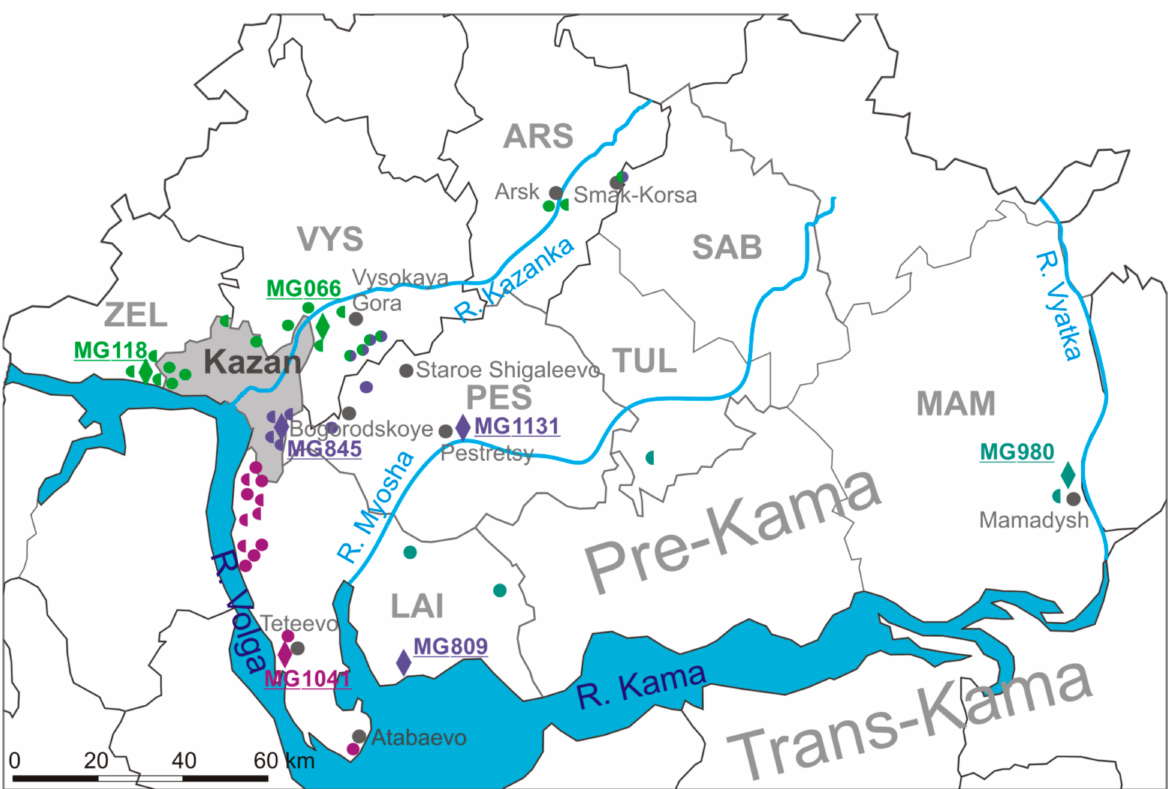
Figure 2. The map of Puumala orthohantavirus (PUUV) infection site locations and bank vole trapping sites in the Republic of Tatarstan. Semicircle—PUUV genome segment identified in hemorrhagic fever with renal syndrome patient: left semicircle—S segment; right semicircle—M segment. Multicolored circles represent reassortant genomes. Diamond—bank vole trapping site. Names starting